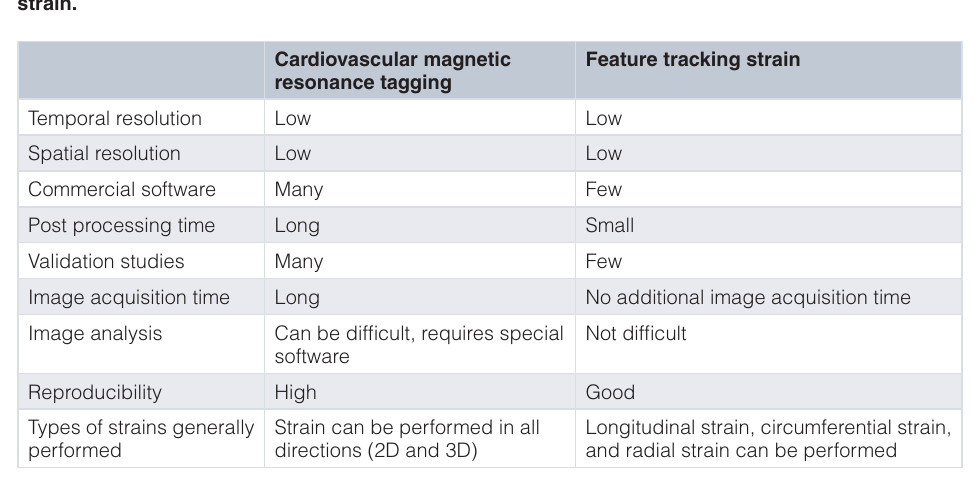
Table 1. Differences between cardiovascular magnetic resonance tagging and feature tracking